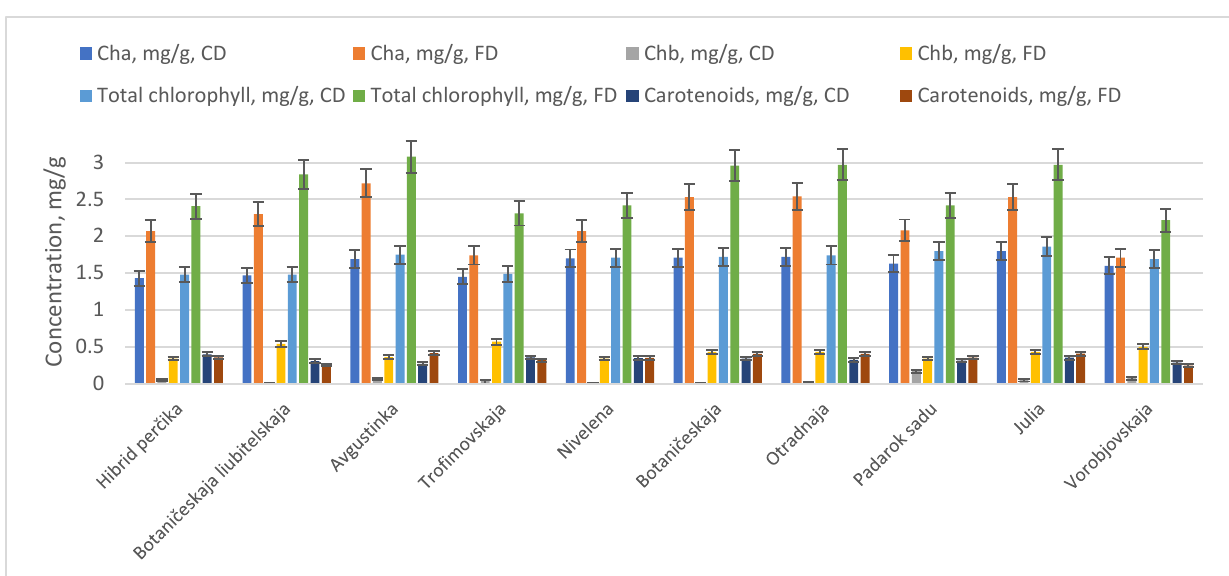
Figure 1. Total amounts (mg/g) of chrolophyll A (Cha), chlorophyll B (Chb), and carotenoids in convection-dried (CD) and freeze-dried (FD) HR cultivars’ leaf powders.